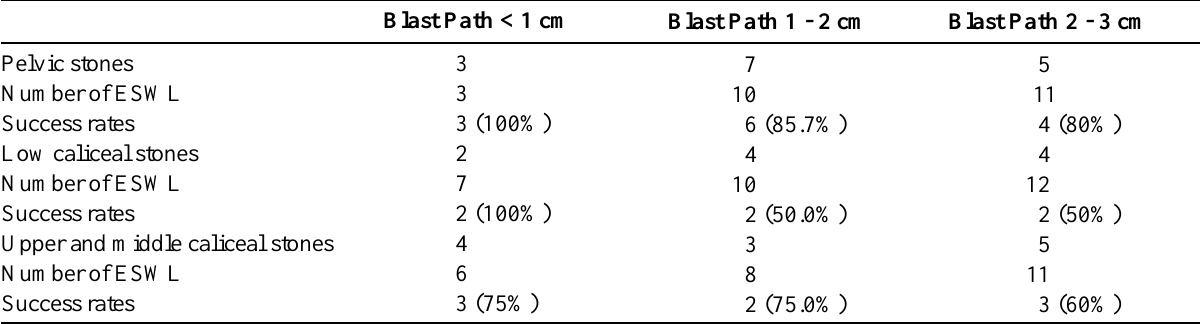
Table 1 – The outcome of ESWL in the treatment of renal pelvicalyceal stones sized between 6 and 20 mm in morbidly obese patients.